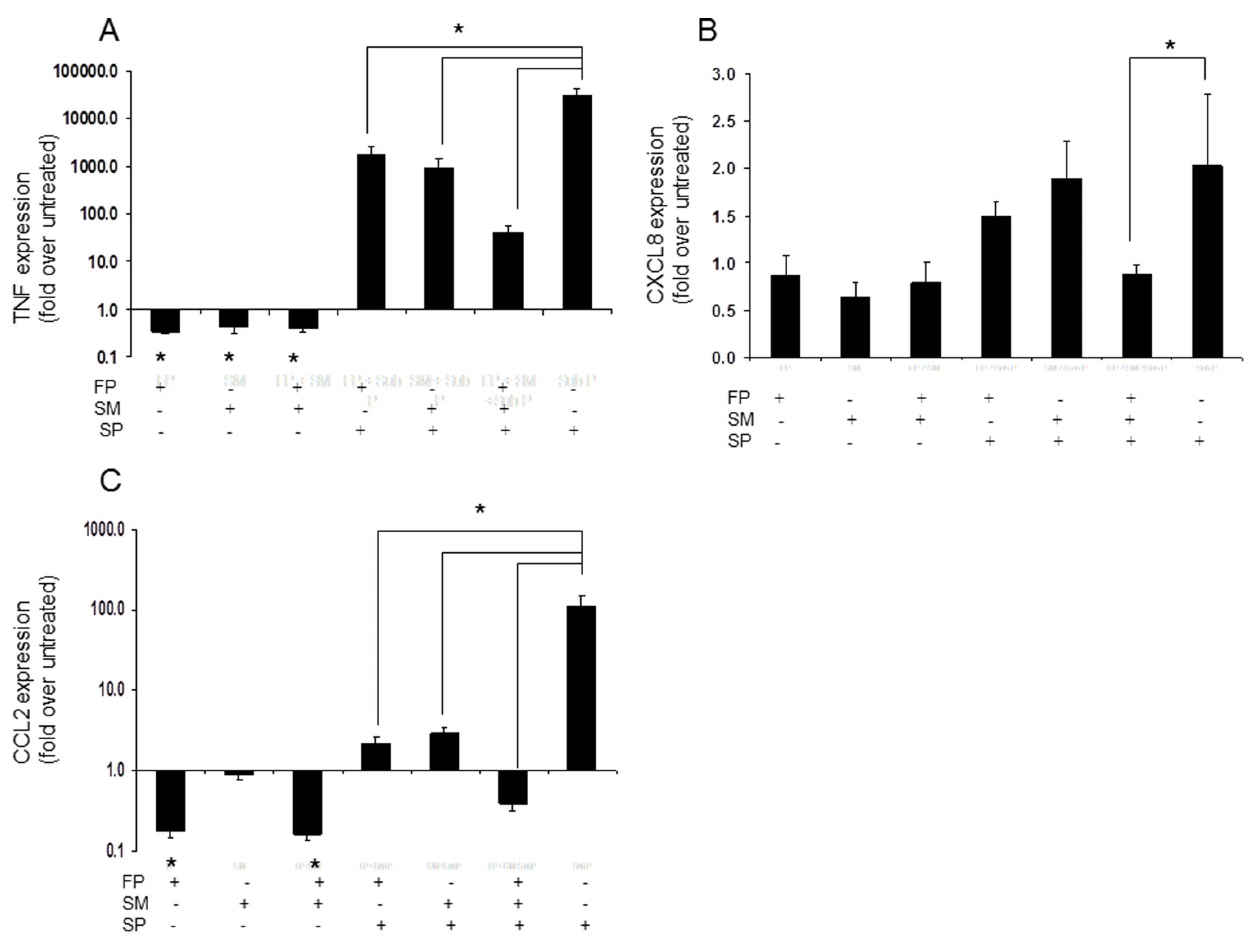
Figure 3. Fluticasone and salmeterol inhibit SP-induced production of TNF and chemokines. A , LAD2 human mast cells were treated with fluticasone (1 uM) or salmeterol (1 uM) or combination for 20 hr, then stimulated with SP (1 ug/mL) for 3 hr and TNF, CXCL8 and CCL2 ( A , B and C respectively) expression was measured by quantitative RT-PCR (n=6, *=p , 0.01 compared to untreated control, unless otherwise indicated).